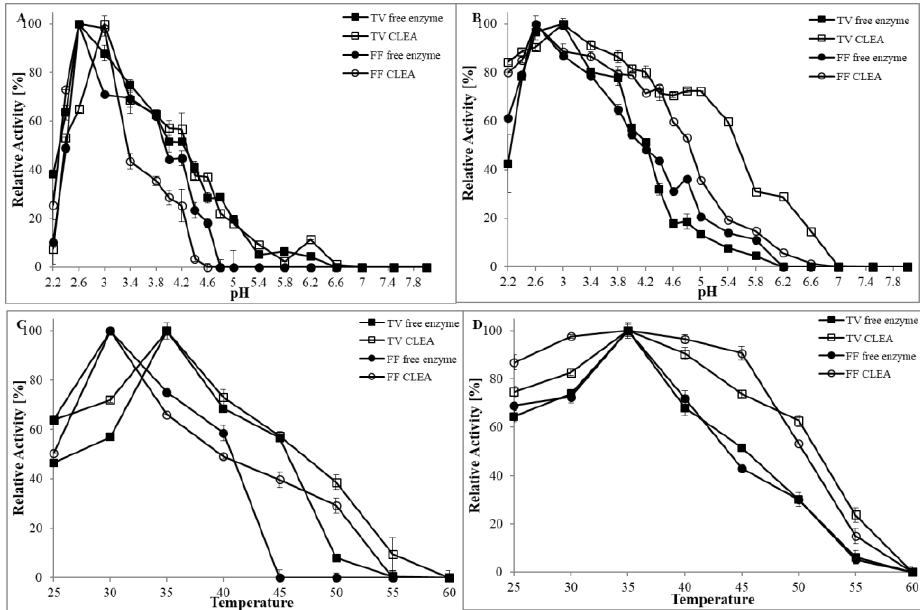
Figure 2. The influence of ( A ) pH optimum and ( B ) pH stability on free and CLEA immobilised laccases from T. versicolor and F. fomentarius . ( C ) The influence of optimum temperature and ( D ) thermal stability on free and CLEA immobilised laccase from T. versicolor and F. fomentarius .